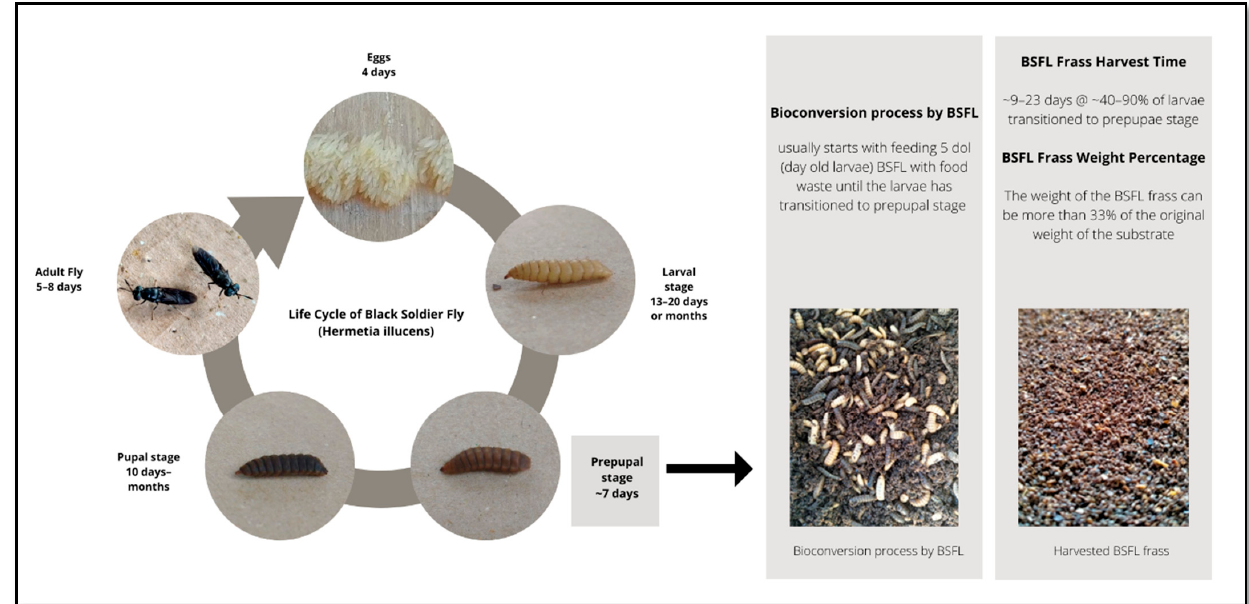
Figure 1. Life cycle of black soldier fly and the production of BSFL frass. BSFL can feed and grow on a broad range of decaying plant and animal matter, including manure, food waste, municipal waste, and rotting plant material [11]. They can eliminate more than 50% of total organic waste in a short period (two weeks) under ideal conditions [12,13]. BSFL is unique in that it can convert organic wastes into protein and fat-rich biomass that is safe for animal consumption and, thus, is suitable as a substitute for the standard proteins in animal diets. The nutritional content of the larvae, about 40% larval protein and 30% larval fat, is beneficial for producing goods, such as animal feed and biodiesel [14]. In the emerging industry of insects for food and animal feed, the second by-product generated in a large quantity in BSFL composting is frass. BSFL frass is a compost-like material generated by feeding low-quality organics to BSFL living in high larvae density with bacteria. BSFL frass could recapture nitrogen and phosphorus from the already existing food chain to be reused as fertiliser and reduce the demand for chemical fertilisers [15]. Potential revenue loss may come from BSFL frass because of high potential in producing high-value products, such as fertiliser, biochar, and fish feedstock. To avoid revenue losses on BSFL frass, studies on the characteristics of BSFL frass are needed [3]. It is essential to determine the benefits and challenges of using BSFL frass [15]. Not much is known about the challenges in using food waste as a substrate to produce BSFL frass and the post-treatment of BSFL frass. Therefore, this paper aims to determine the characteristics, benefits, and applications of BSFL frass. It will also investigate the challenges of using food waste substrate to produce BSFL frass, the suitable pre-treatment of the food waste substrate and the post-treatment of BSFL